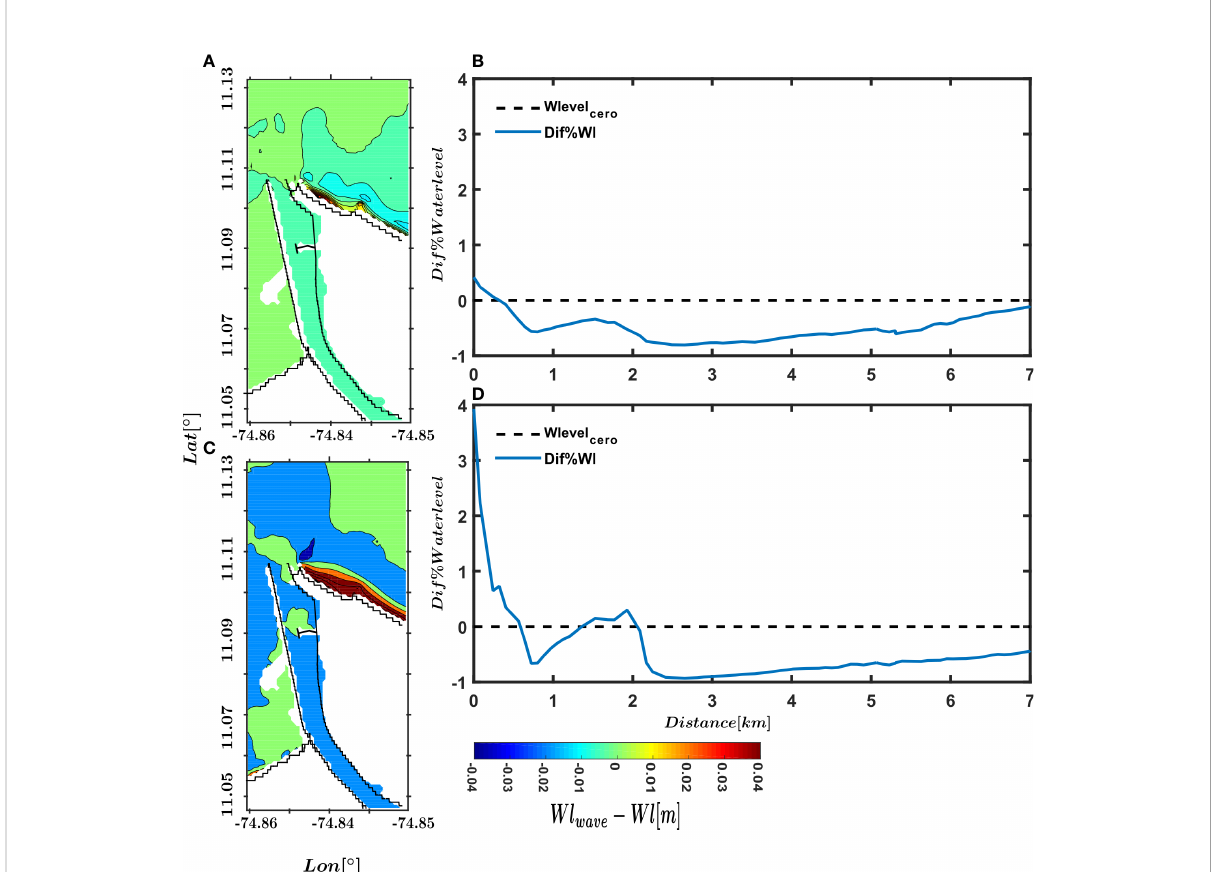
FIGURE 6 Difference of water level averaged in tidal cycle with and without waves effects for (A) 2018 and (C) 2020. Percentage difference of water level averaged in tidal cycle with and without the effects of waves in a. Longitudinal section in (B) 2018 and (D)